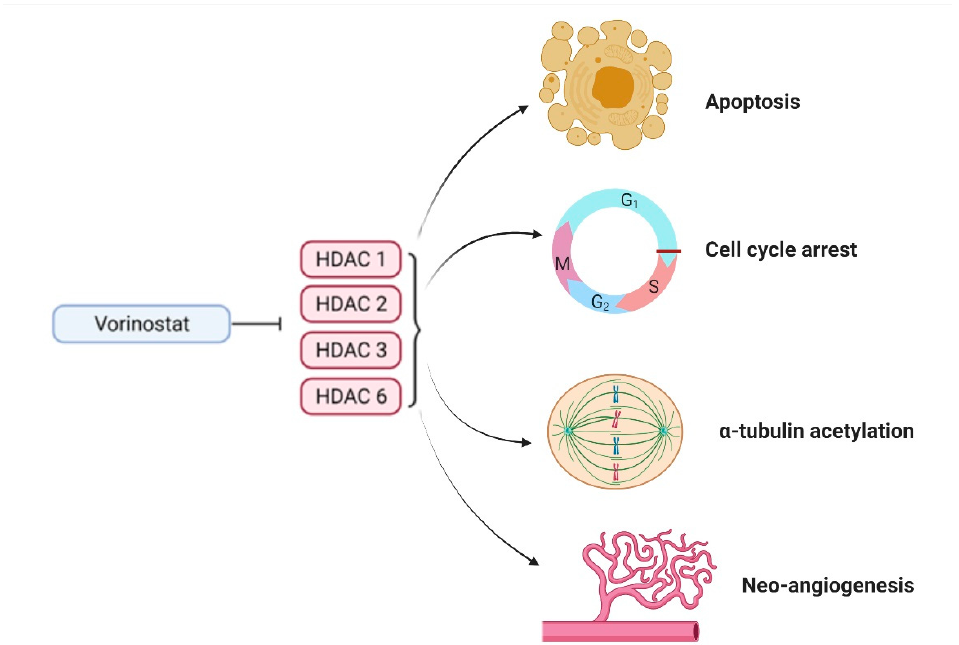
Figure 4. Multiple mechanisms of action of vorinostat in NSCLC.